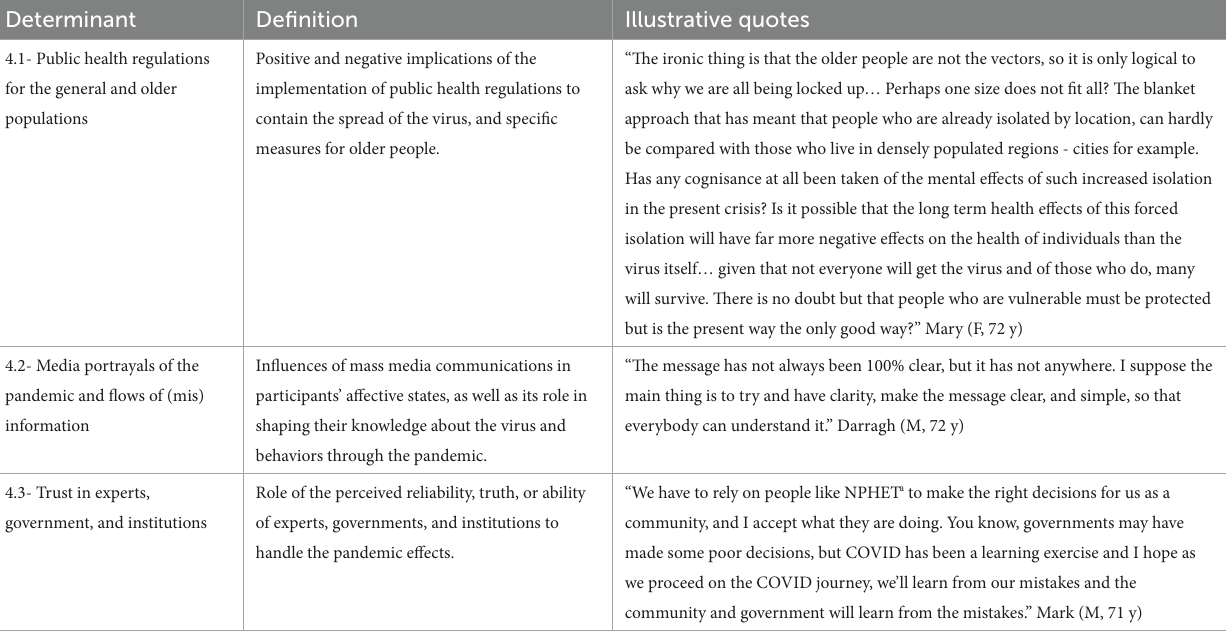
TABLE 5 Detailed socio-ecological determinants at the exo-system (L4).